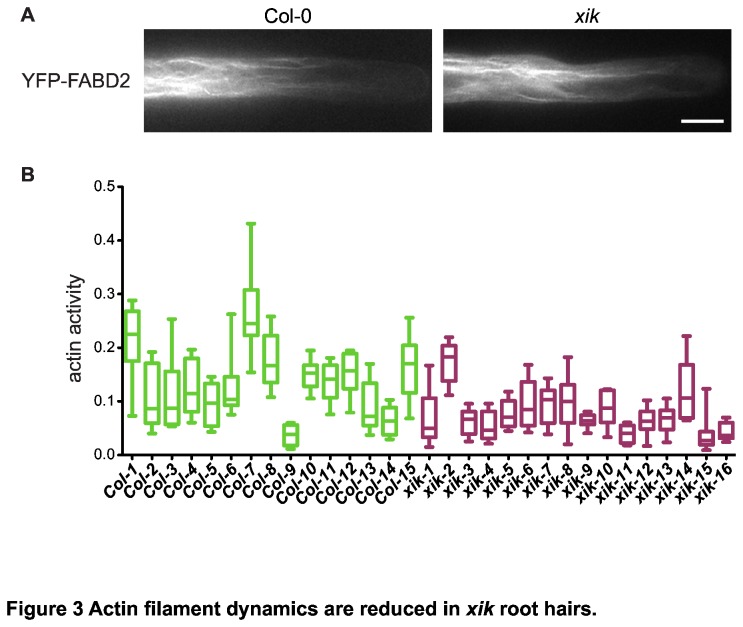
Actin filament dynamics are reduced in xik root hairs.(A) Actin filament organization as labeled with YFP-FABD2 is similar in xik and Col-0. Images are single frames from time-lapse observations in cells Col-3 and xik-3 in panel B, respectively.(B) Actin filament activity in wild type (Col) and mutant (xik) root hair cells (see Movie S2) as determined by the decay of image cross-correlation with increasing time intervals (for details see Figure S2). Box-and-whiskers plot indicate median, 25th and 75th percentile, as well as minimal and maximal decay constants for the ten most active regions in a given cell. Mean activity levels in Col-0 are significantly higher than in xik (Mann-Whitney test; p < 0.01).